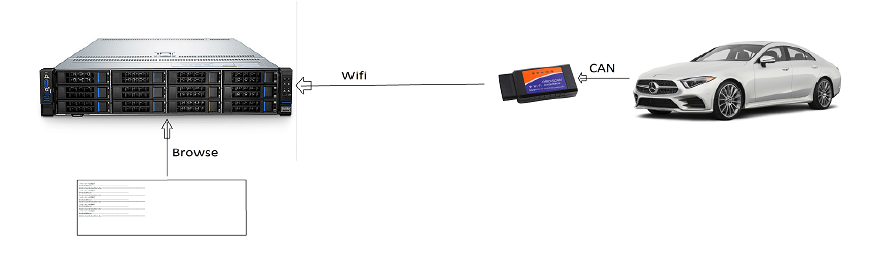
Figure 4. Collecting data using OBD device and WiFi [29].